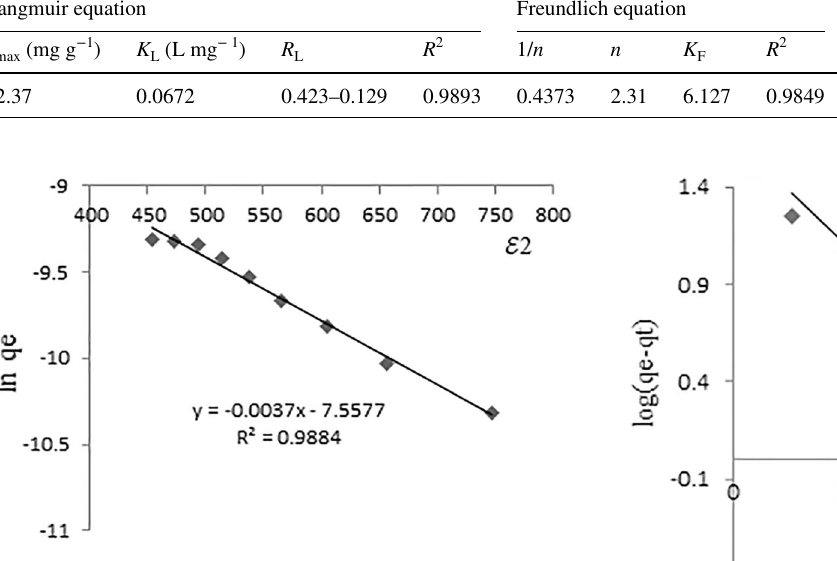
Fig. 5 D–R plots for sorption (pH 6, time